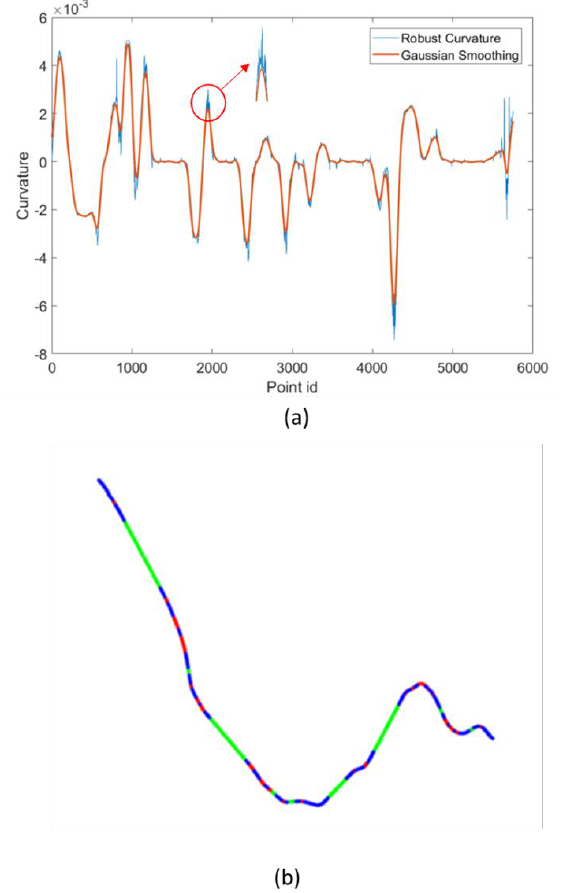
Figure 7. Alignment geometry classification. (a) The curvature plot is smoothed to remove noise and simplify the geometry classification process. (b) The alignment points are grouped according to three possible geometries: straight lines (green), circular arcs (red) and clothoids (blue).